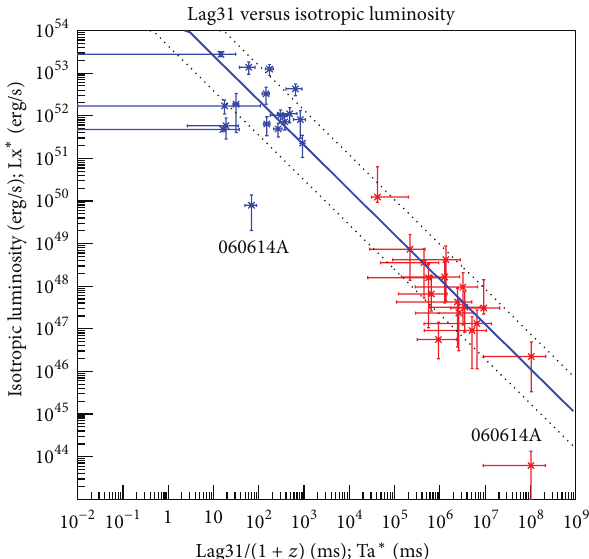
Figure 4: The lag between 50–100 keV and 15–25 keV versus isotropic peak luminosity with X-ray break time versus X-ray luminosity. The blue points are lag-luminosity results. The data reported in Dainotti et al. 2013 are shown in red. The blue lines are best fit values of power-law . The correlation coefficient is − 0.96 with sample size of 32. fitting. The black dotted lines show the region corresponding to variance 𝜎 𝐿 iso